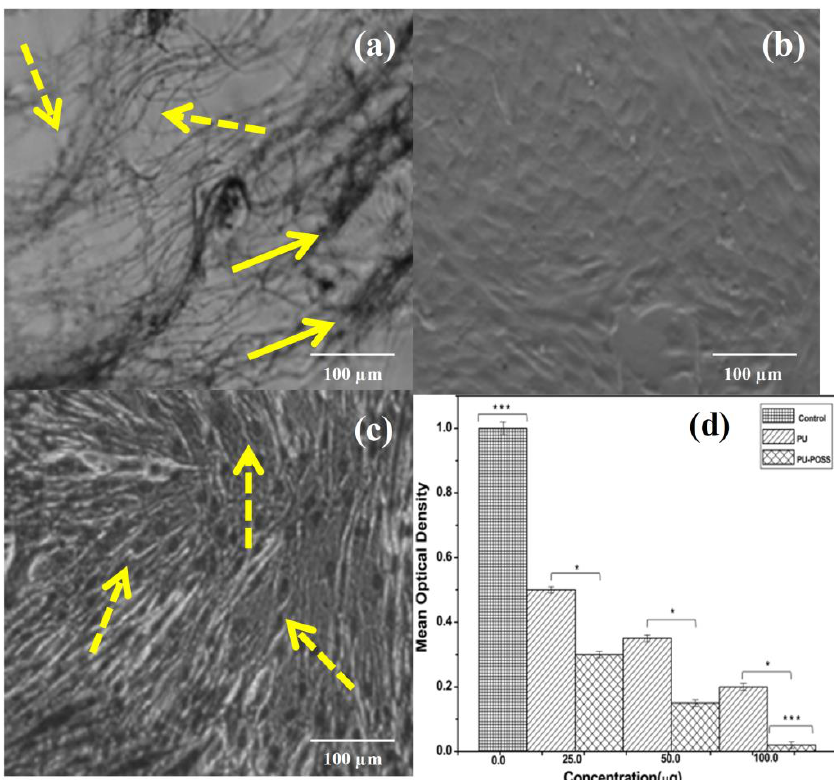
Figure 7. Microscopic metaphors of ( a ) growing myoblasts on POSS-grafted PU nanomatrix. Dashed bright yellow arrows point to POSS molecules, whereas solid arrows indicate spreading of myoblasts ( b ) confluent growth of C2C12 cells just prior to differentiation ( c ) Giemsa tinge depiction of myotube creation with prominent nuclei (dashed yellow arrows) during differentiation in petite quantity of serum. Bar graph illustration of ( d ) OD (600 nm) of spent culture supplemented with varying amounts of PU and POSS-grafted PU (100% expansion symbolize S. aureus in culture medium without nanomatrices). Significant difference (* p ≤ 0.05) was observed in the inhibition of bacteria between the control group and treatments at all concentrations. In addition, there is a significant difference in the bacteriostatic effect on PU and POSS-grafted PU nanomatrix at a high concentration. * p ≤ 0.05, *** p ≤ 0.001 significantly different from inoculated